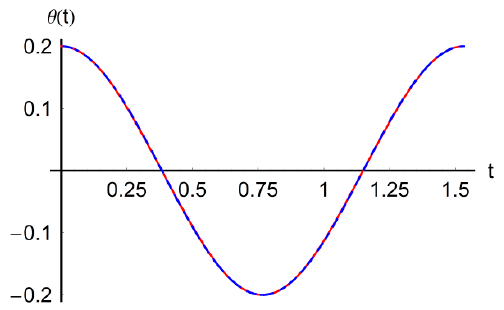
Figure 20. Comparison between the approximate solution (50) and numerical integration results for